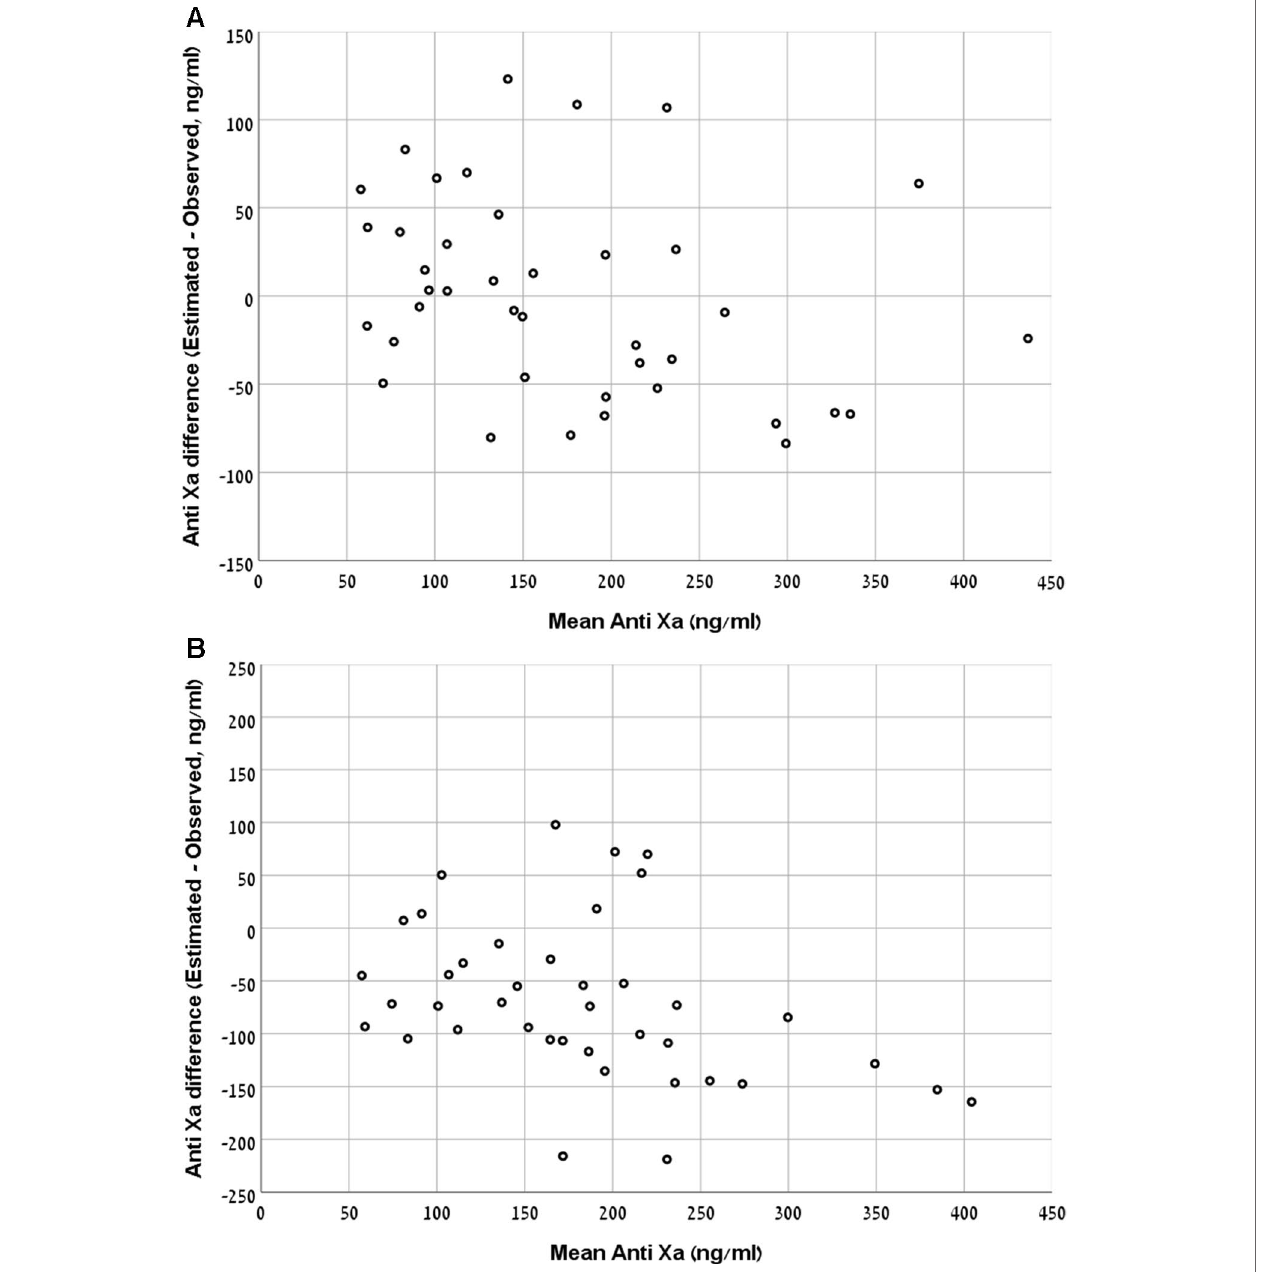
FIGURE 5 | (A) Bland and Altman plot demonstrating the mean value of observed and expected Anti-FXa versus the difference between them in the apixaban derivation cohort. (B) Bland and Altman plot demonstrating the mean value of observed and expected Anti-FXa versus the difference between them in the apixaban validation